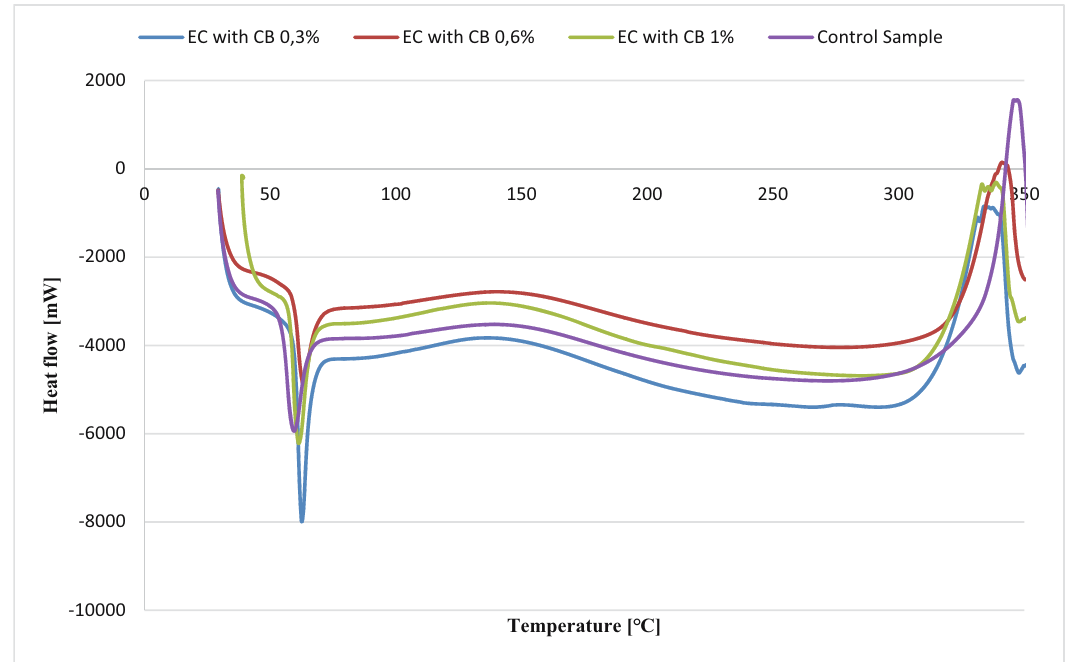
Figure 10: DSC results of Neat ( control sample ) and 0.3, 0.6 and 1 wt% carbon black added